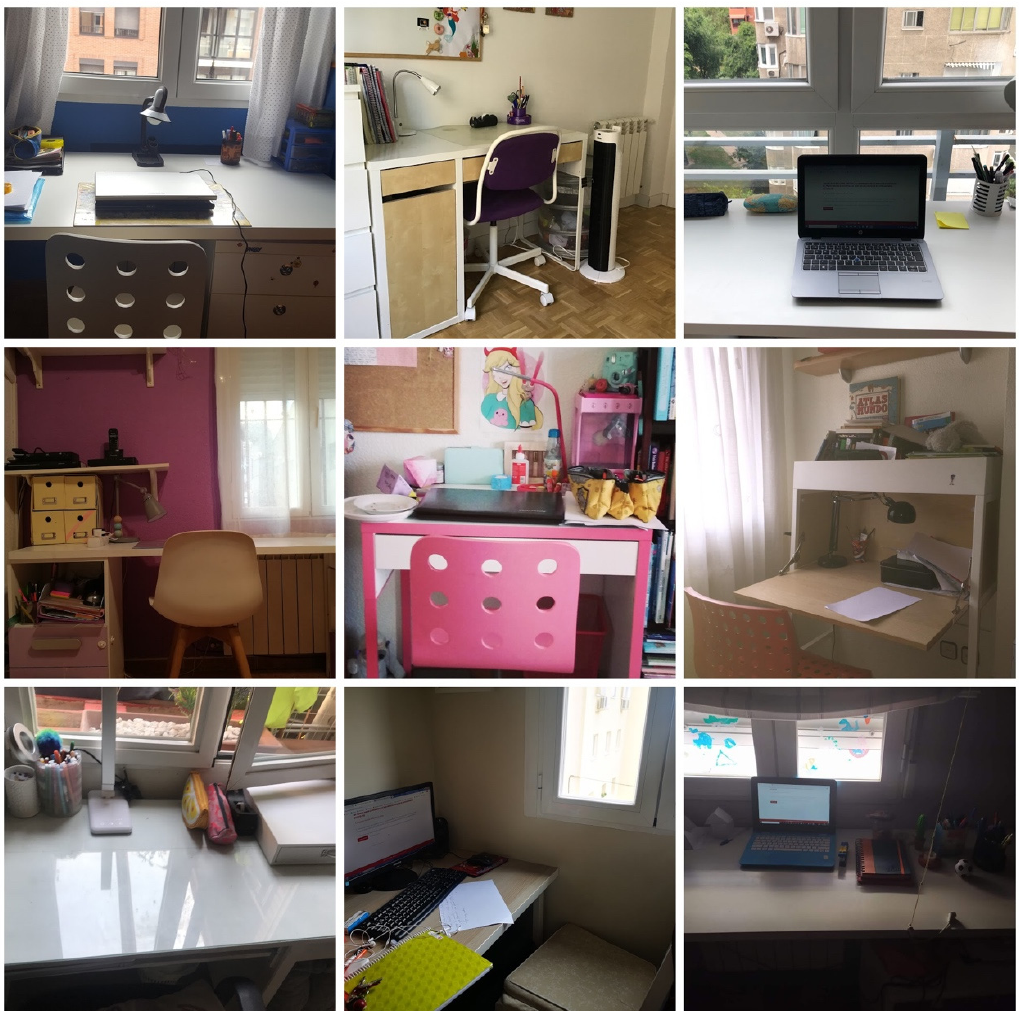
Figure 1. Exclusive or usual spaces for tele-studying, many equipped with computers.